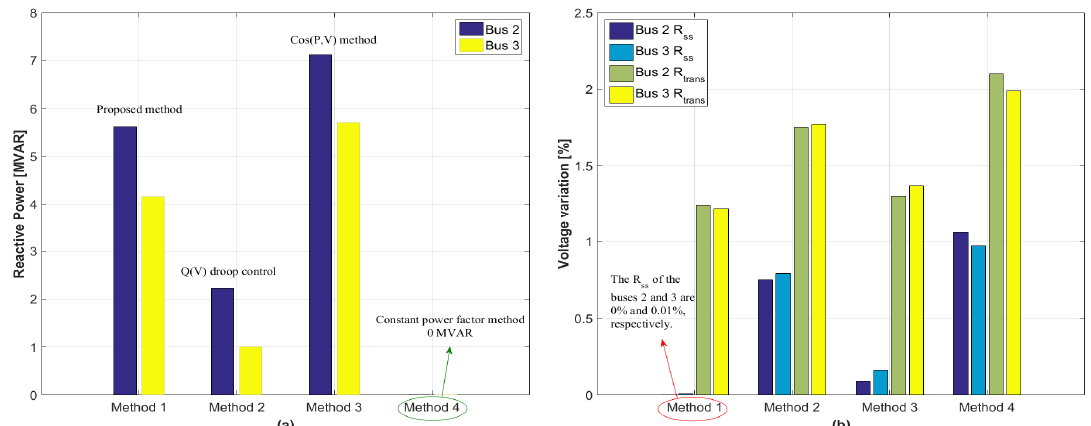
Figure 6. Comparison results for minimization of voltage variation in Case 1. ( a ) Total reactive power generation at buses 2 and 3 ( b ) Voltage variation at buses 2 and 3.